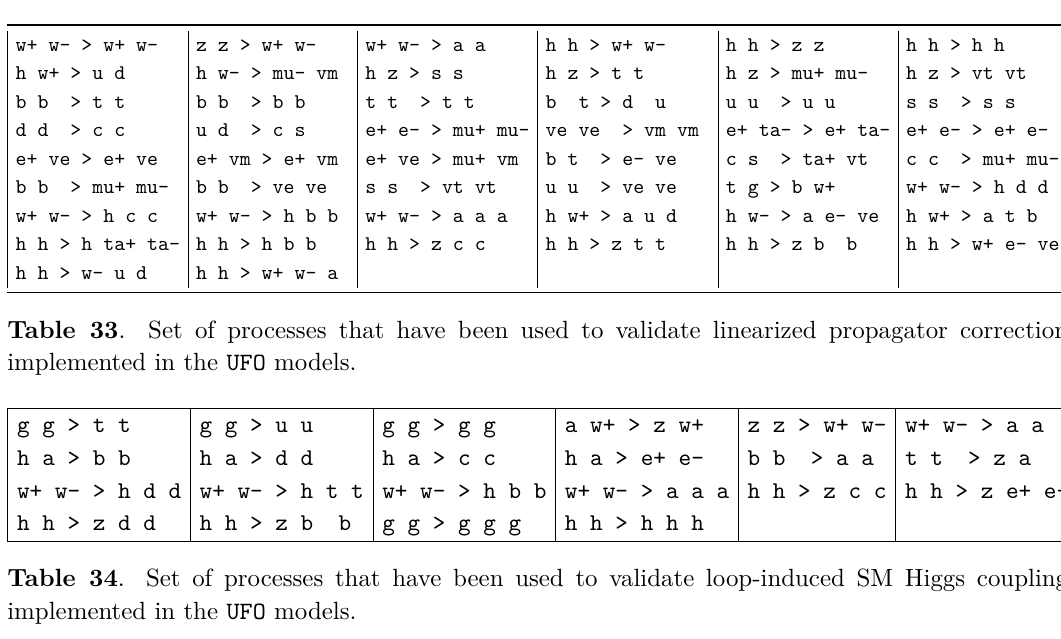
Table 32 . Set of processes that have been used to validate the UFO models.